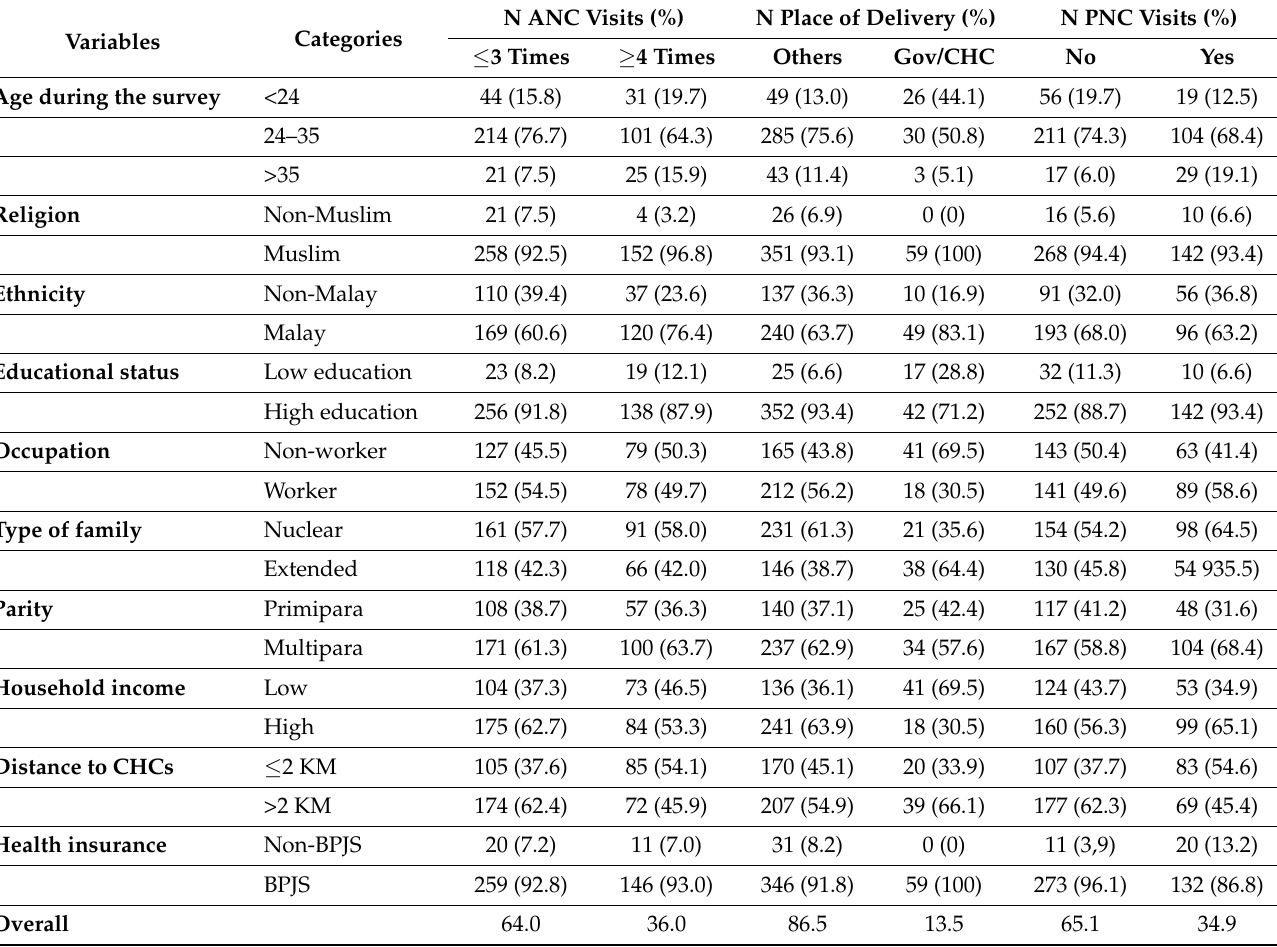
Table 3. Utilization of maternal health services at community health centers by sociodemographic characteristics of the respondents, Municipality of Jambi, Municipality of Sungai Penuh, and Meran- gin Regency, Province of Jambi, 2021 (n =